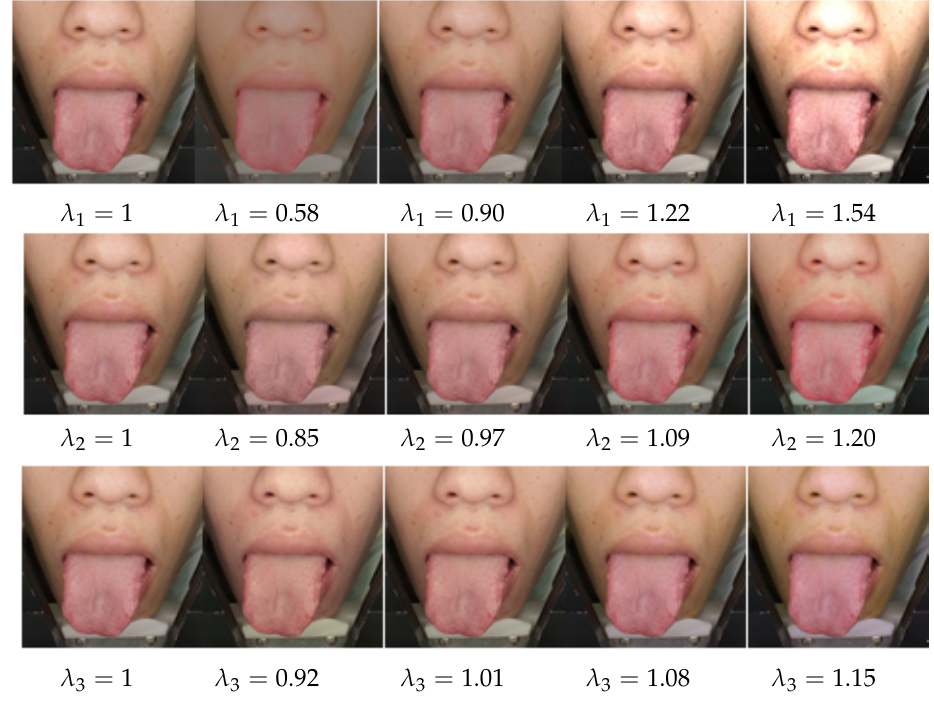
Figure 14. The effects of the user parameters.